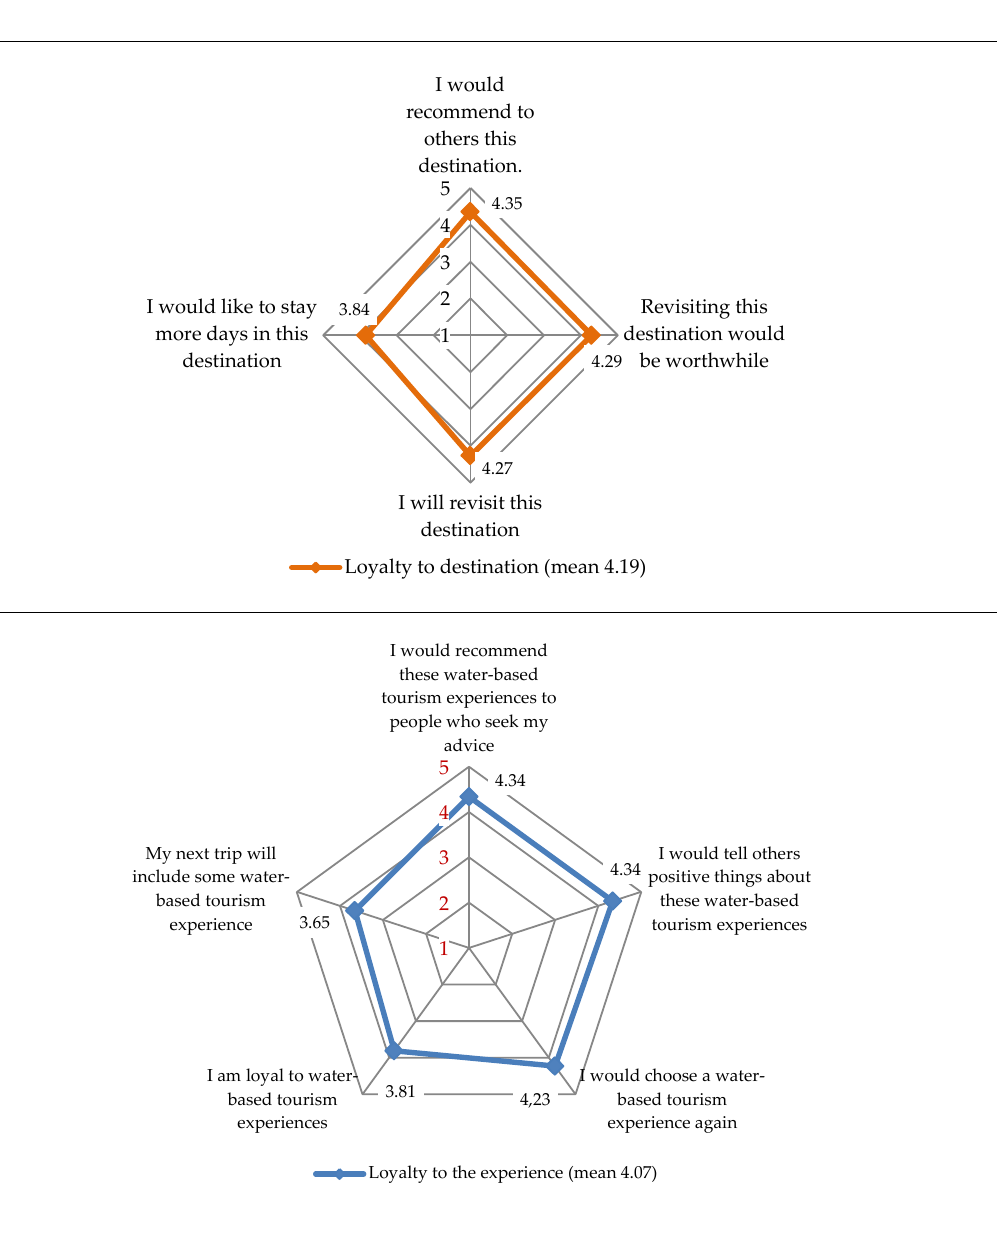
Figure 8. Assessment of the variable